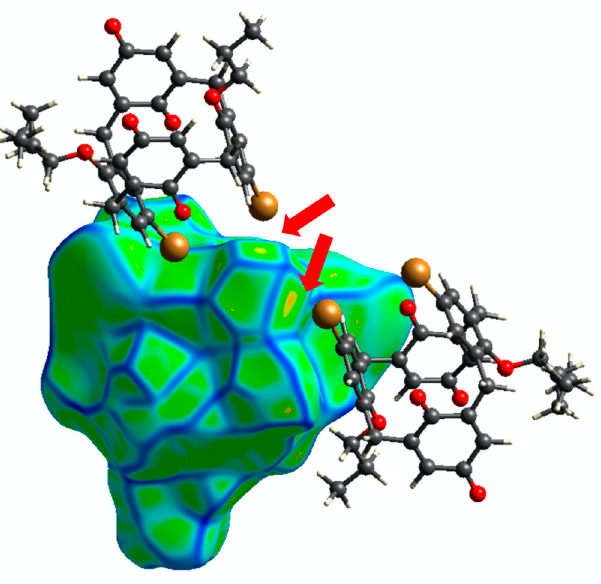
Figure 10. The Hirshfeld surface mapped over curvedness highlighting the weak Br ··· Br contact red arrows.